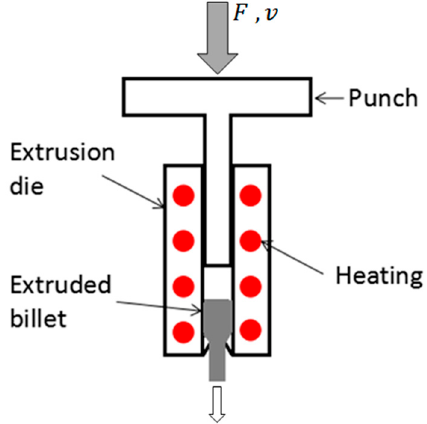
Figure 3. Schematic diagram of the hot extrusion process ( F : extrusion force; v : velocity).